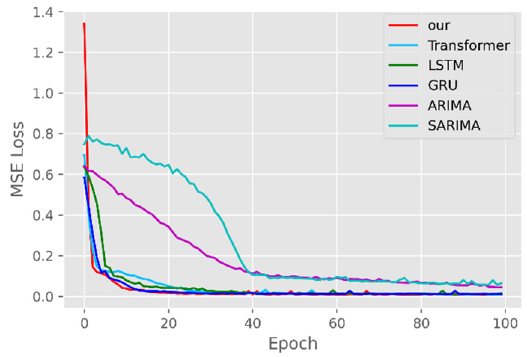
Figure 8. Comparison of training loss for NY cases and deaths.